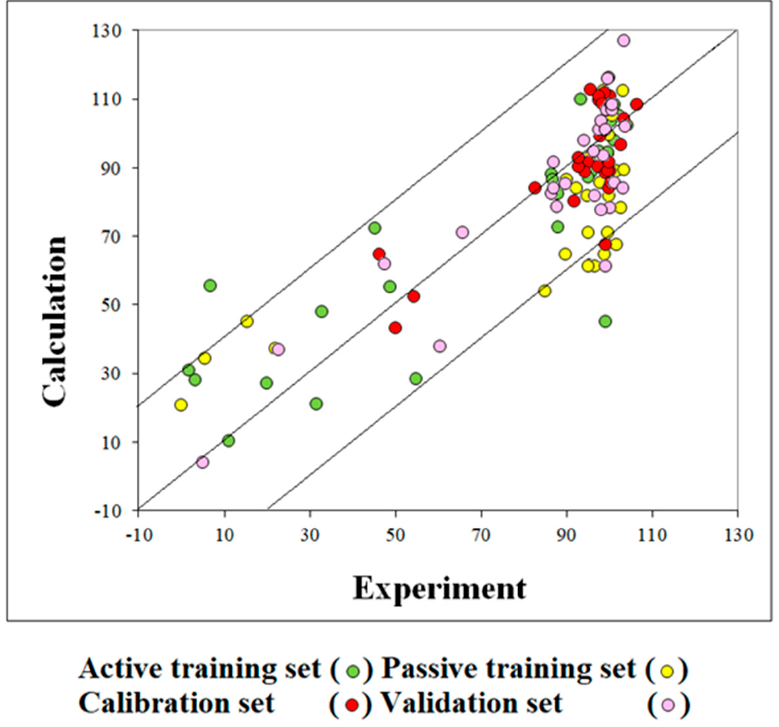
Figure 1. Graphical representation of the model for cell viability in THP-1 cells, which is influenced by different metal nano-oxides under different concentrations.